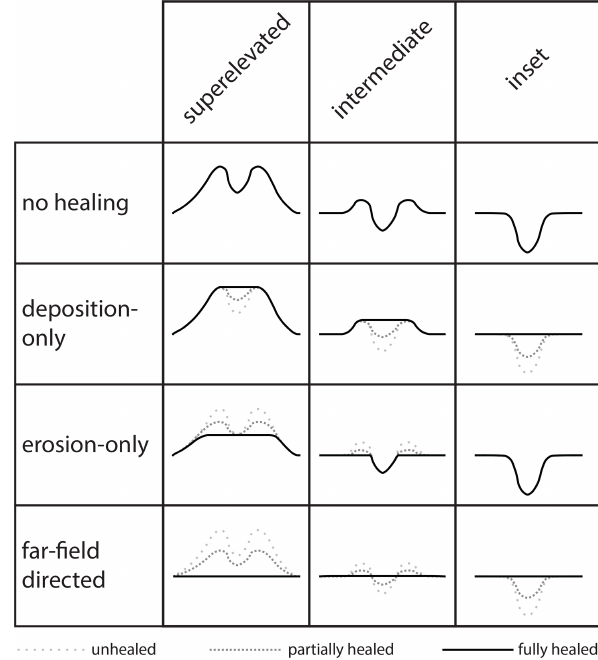
Figure 4. Potential healing modes for different initial conditions of abandoned channels. Each healing mode has different endpoints de- pending on the initial channel emplacement: deposition-only mode adjusts each abandoned channel cell’s low elevation toward its high elevation, erosion-only mode adjusts high elevations toward low elevations, and far-field-directed mode adjusts both elevations to- wards the far-field floodplain elevation. As such, the deposition- only and erosion-only modes can result in topography that main- tains positive topographic relief even once fully